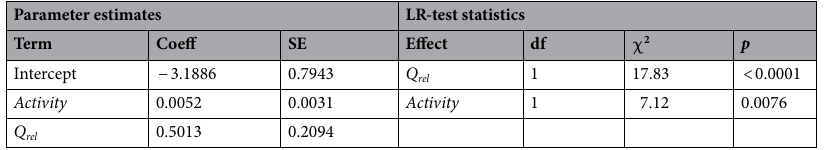
Table 2. Logit-parameter estimates (modell averaged) and corresponding likelihood-ratio test statistics for the most supported GLM fitted to predict fish passage probabilities in PIT-tagged Atlantic salmon smolts from the